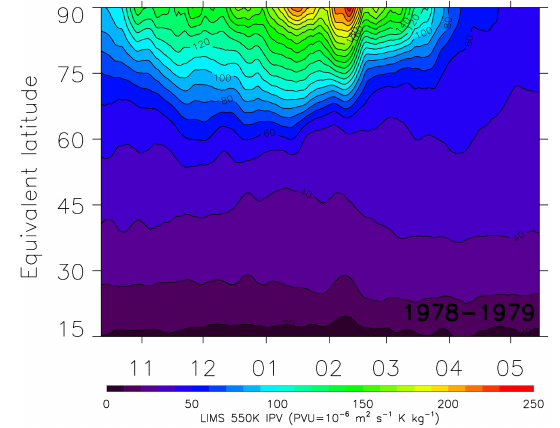
Figure 16. Time series of LIMS isentropic PV vs. equivalent lati- tude at 550K and with smoothing over 7 days. PV contour interval (CI) is 10